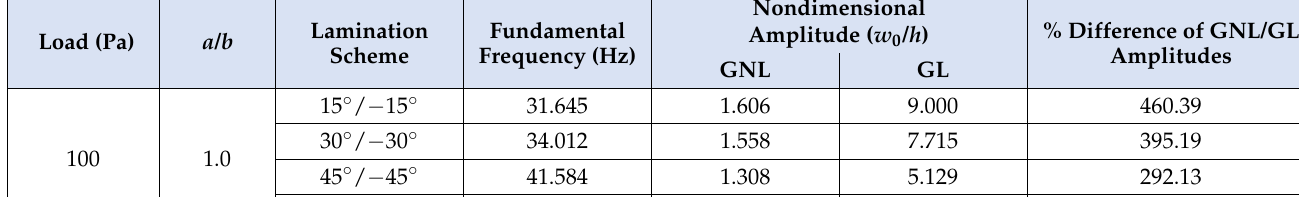
Table 2. Fundamental free-vibration frequencies (Hz) and peak amplitudes.